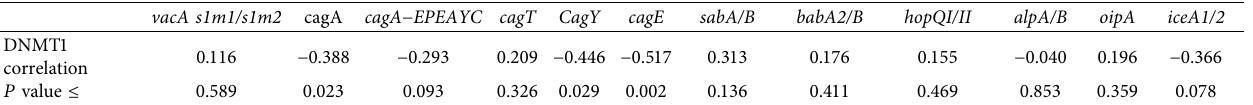
Table 8: Correlation between DNMT1 gene Δ Ct in gastric antral epithelial cells of gastritis and gastric adenocarcinoma patients with H. pylori virulence gene cDNAs using the Spearman test.